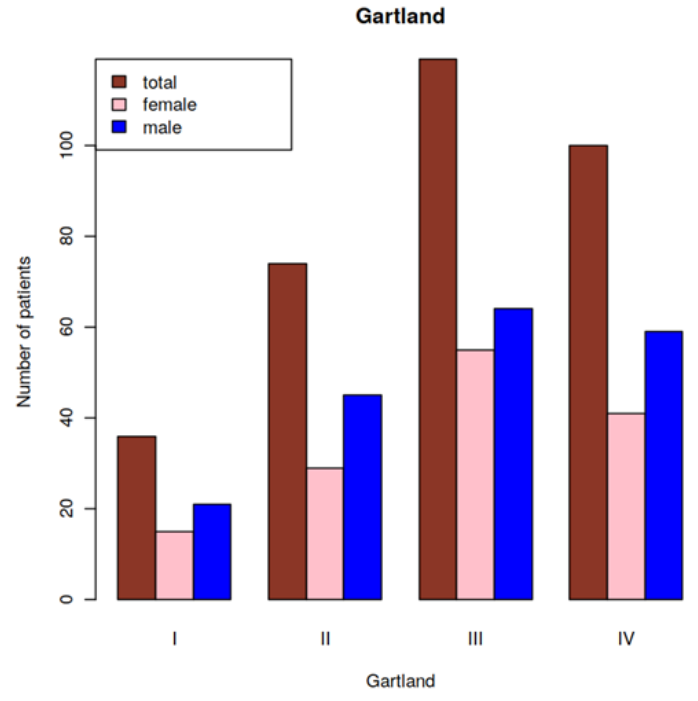
Table 2. Mean values and variation of Gartland scores and patients’ ages at baseline. All Patients ( n = 329)